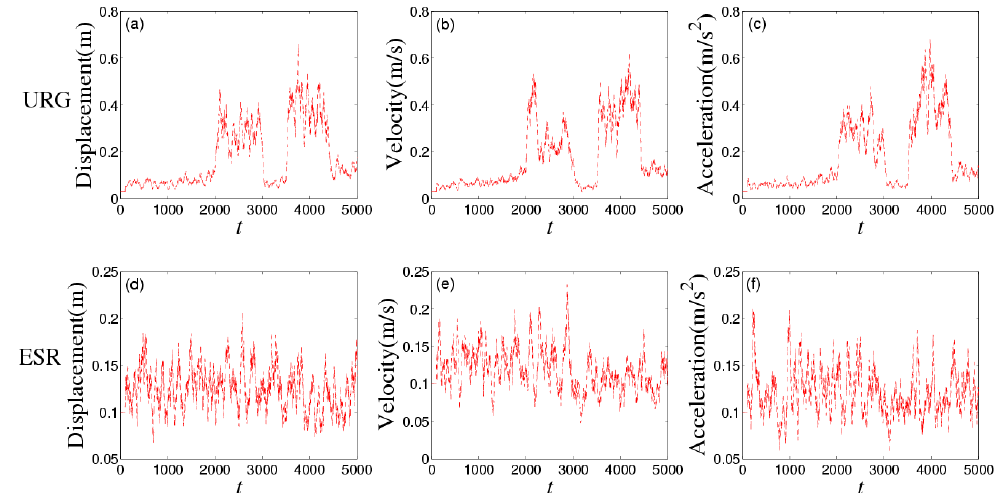
Figure 13. The measurement noise V-C matrix R of the local-filter output of URG and ESR in the second experiment (The R of displacement of ( a ) URG and ( d ) ESR, the R of velocity of ( b ) URG and ( e ) ESR and the R of acceleration of ( c ) URG and ( f ) ESR).